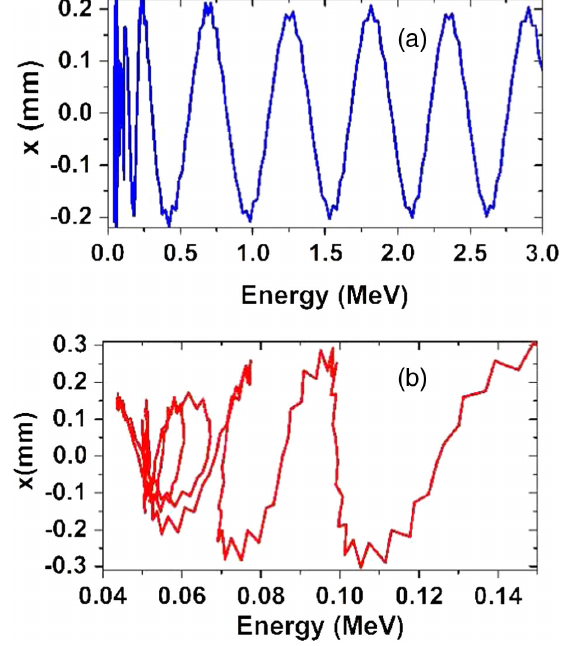
FIG. 15. x vs energy plot for the (a) transmitted, and (b) lost, particles.